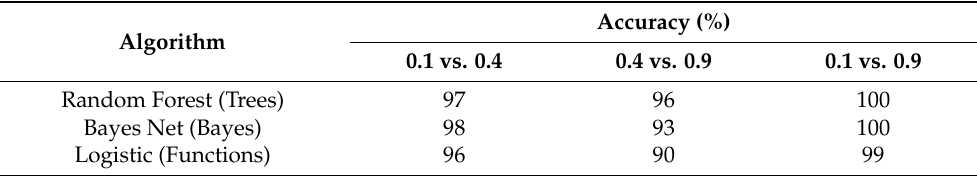
Table 2. The accuracy of distinguishing the ripening stages of ‘Redhaven’ peaches based on a set of textures selected from flesh images in color channels R , G , B , L , a , b , X , Y , and Z .